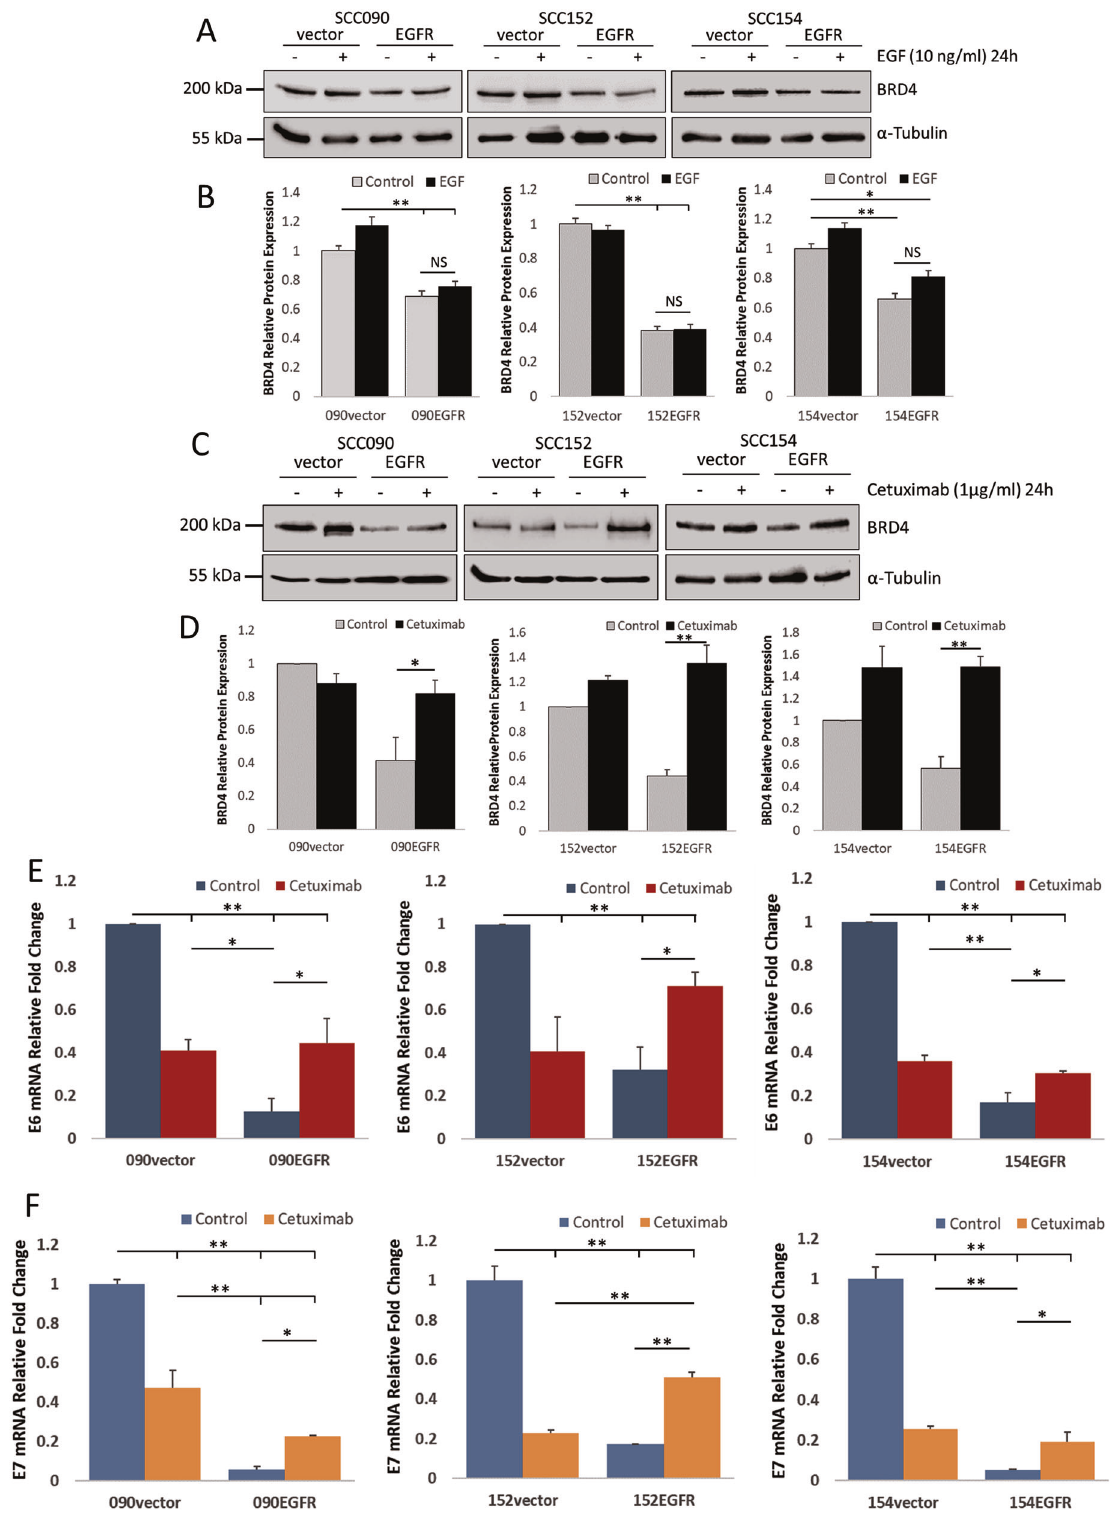
Fig. 3 Responses of HPV-positive HNSCC cells after EGF and cetuximab treatments. A Expression of BRD4 after 24 h of EGF treatment (10 ng/ml). B Quanti fi cation of three independent measurements of BRD4 protein expression after the EGF treatment presented in bar-chart. Statistical analysis was performed by one-way ANOVA (* p < 0.05, ** p < 0.01, NS not signi fi cant). C Expression of BRD4 after treatments with cetuximab (1 µg/ml 24 h). D Quanti fi cation of three independent measurements of BRD4 protein expression after the cetuximab treatment presented in bar-chart. Statistical analysis was performed by one-way ANOVA (* p < 0.05, ** p < 0.01); only comparisons for EGFR-overexpressing cells are shown. HPV E6 ( E ) and HPV E7 ( F ) transcription after cetuximab treatment (1 µg/ml 24 h) measured by qRT-PCR in three independent RNA extractions. Statistical analysis was performed by one-way ANOVA (* p < 0.05, ** p < 0.01).